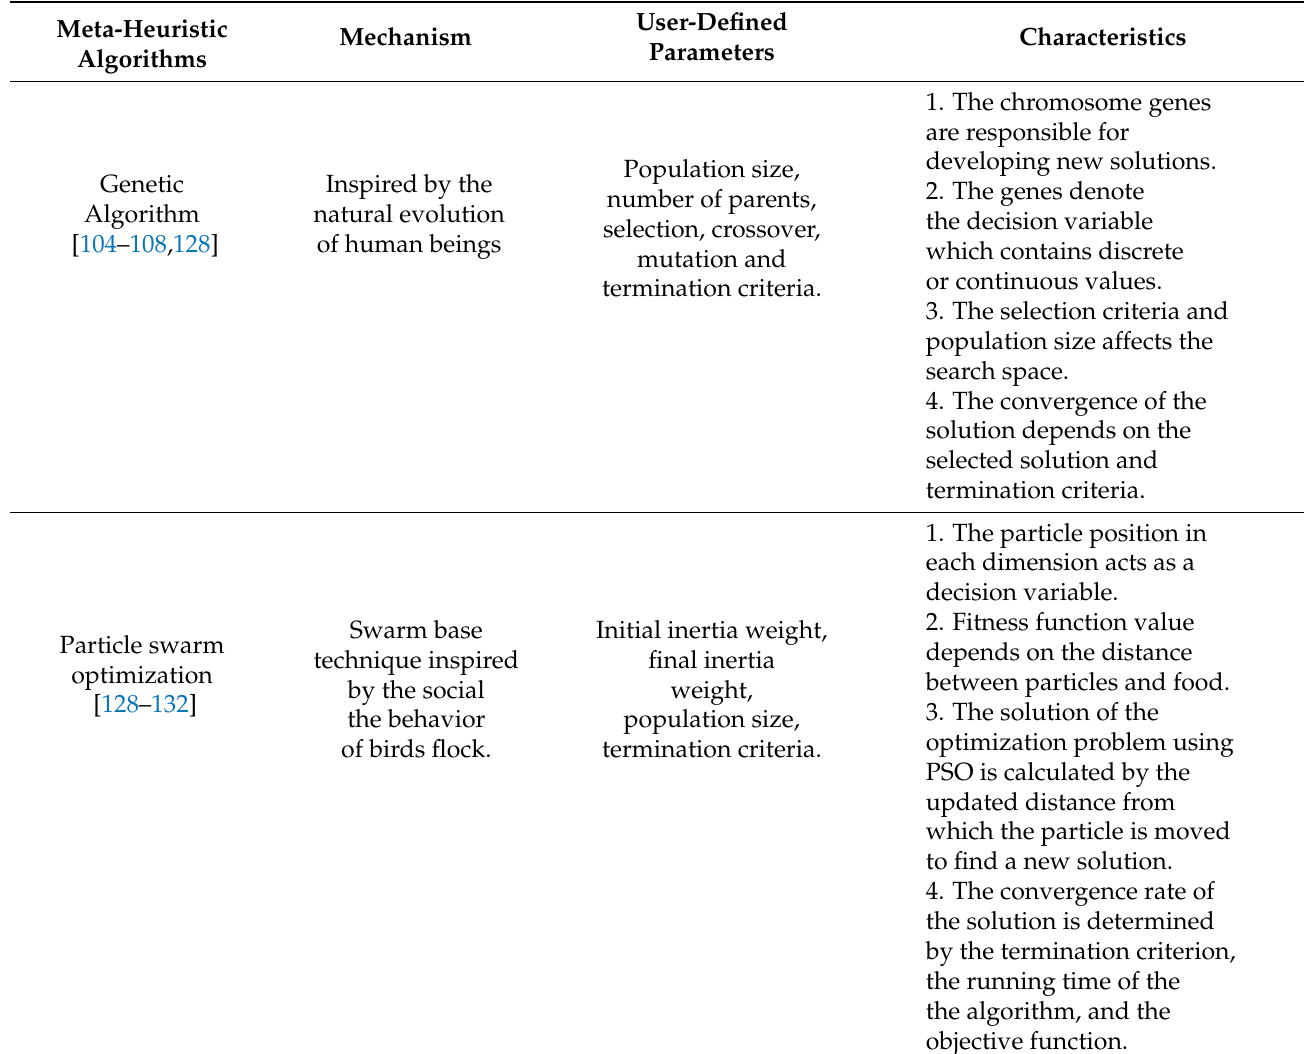
Table 6. Comparison of meta-heuristic algorithms